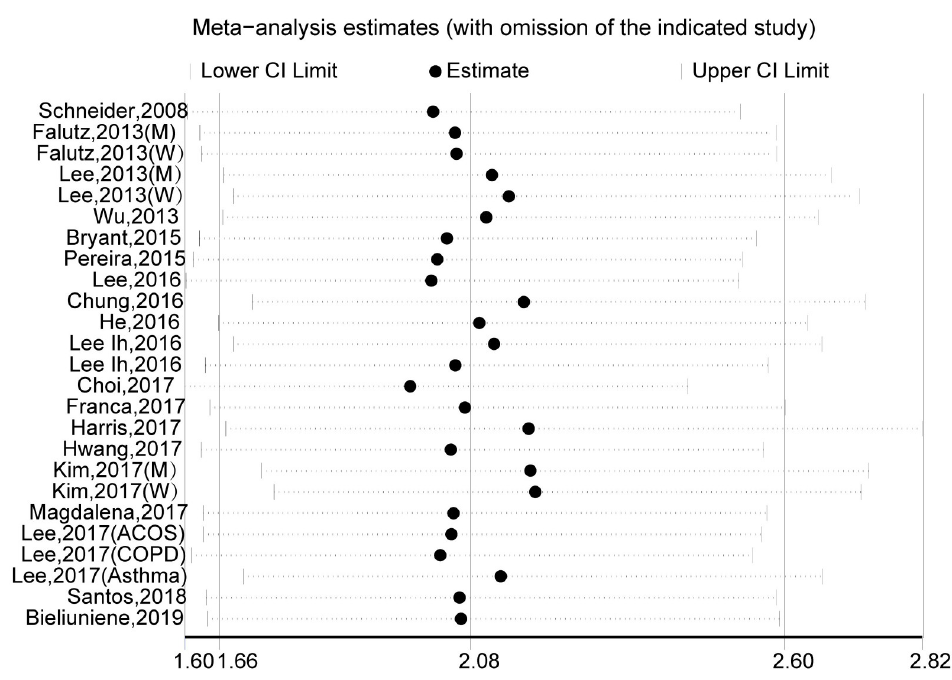
Fig 3. Sensitivity analysis for the estimated effects of sarcopenia on osteopenia risk. The analysis was performed via recalculation of the pooled results of the primary analysis after exclusion of one study per iteration.